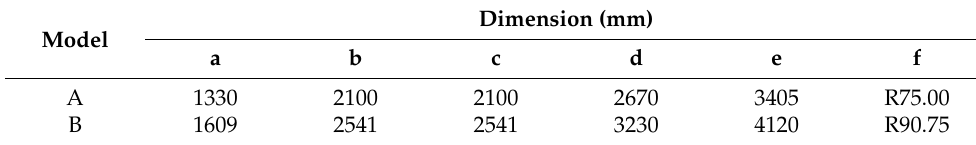
Table 4. Dimensions of crusher models.